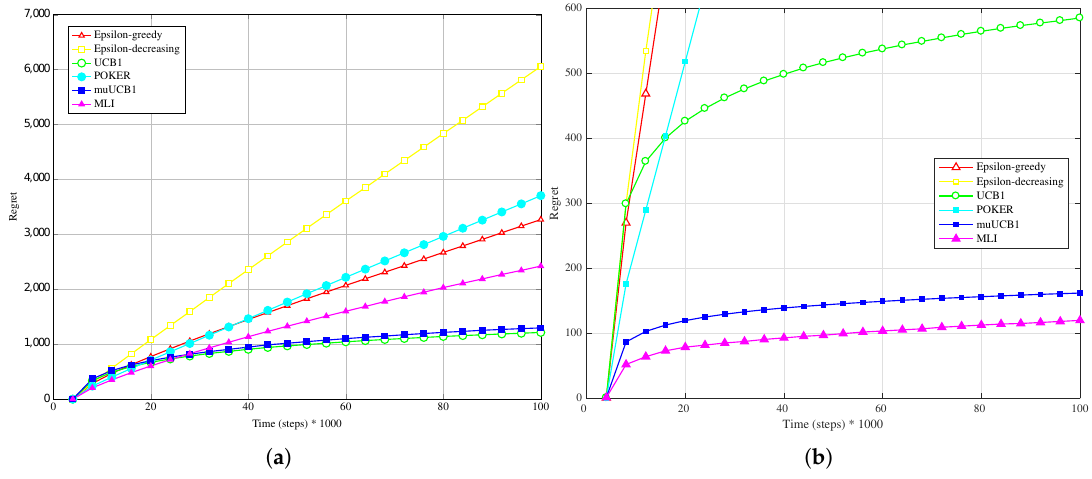
Figure 8. Performance in terms of regret of the six considered algorithms, with a exponential distribution for the reward PDF and T U / T M = 5. ( a ) Hard configuration; ( b ) Easy configuration.